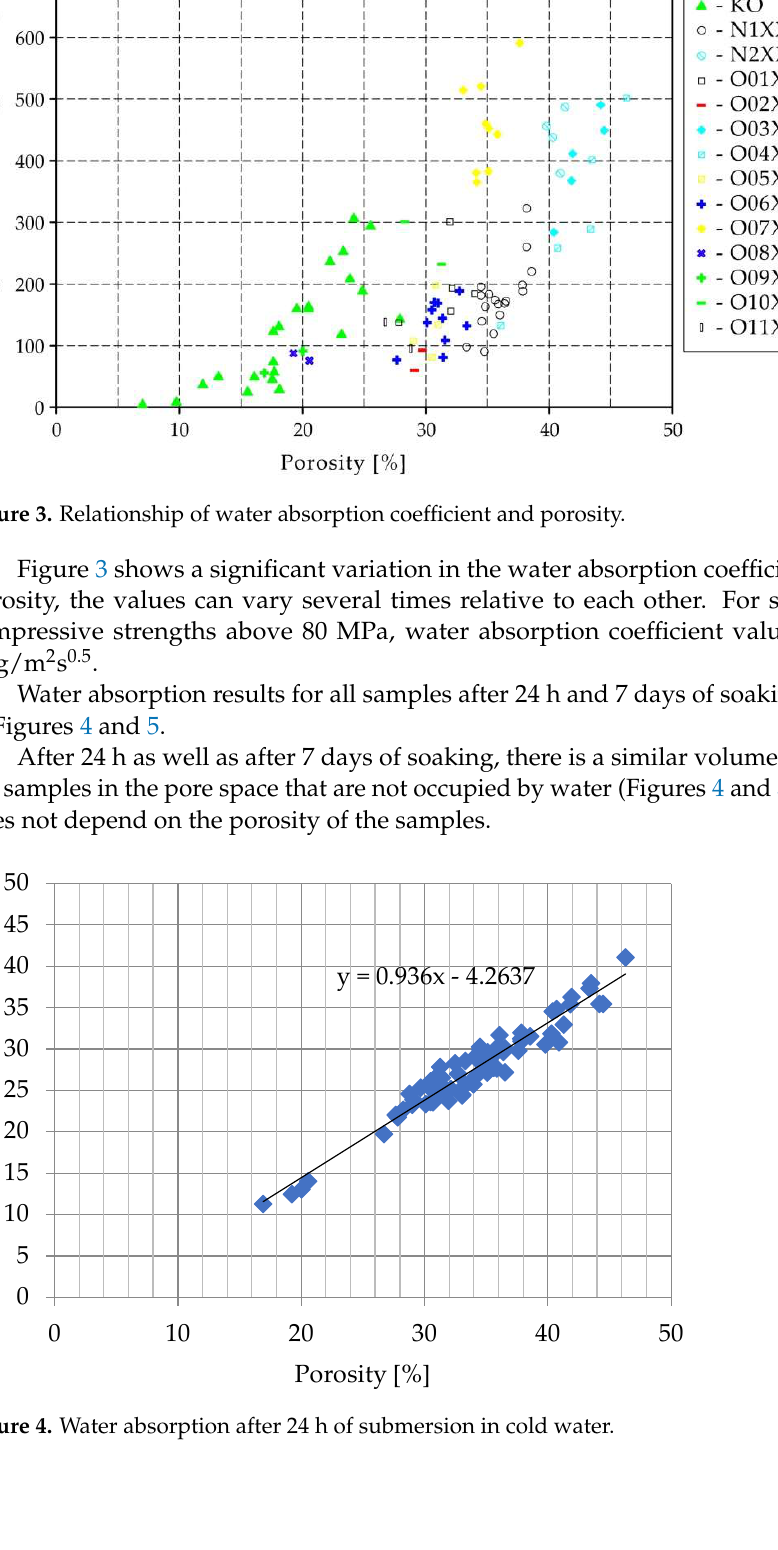
Figure 2. Relationship of compressive strength and porosity.